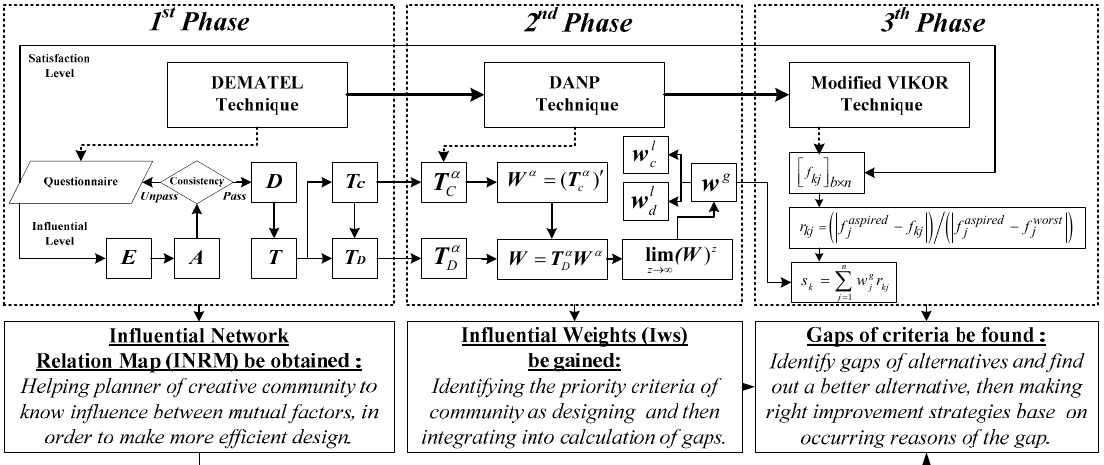
Figure 2. Target and process of the research method.